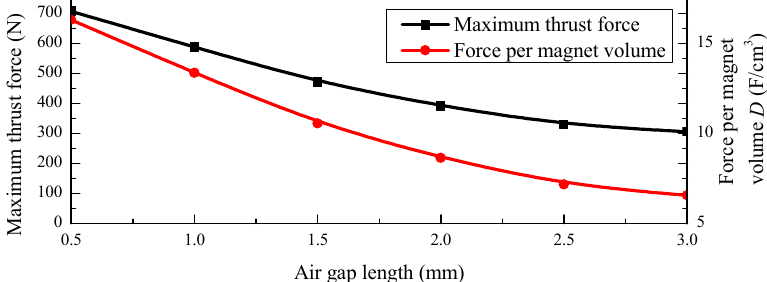
Figure 8. Variation in the maximum thrust force and force per permanent magnet (PM) volume with different air gap lengths.